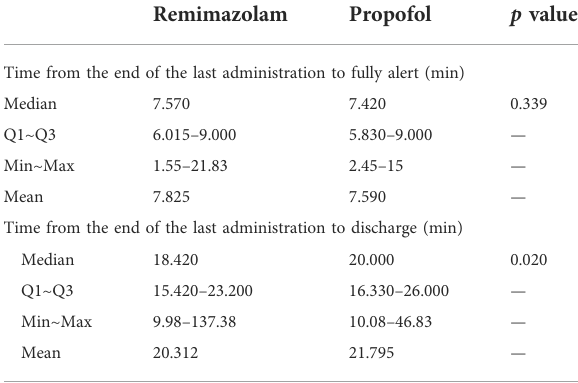
TABLE 8 Time from the end of the last administration of study drug to fully alert and discharge in successfully sedated patients. Remimazolam Propofol p